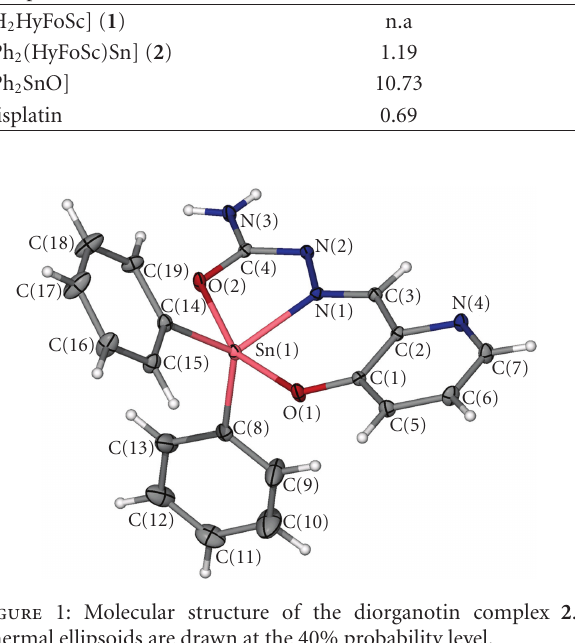
Table 4 for a summary of the cytotoxicity